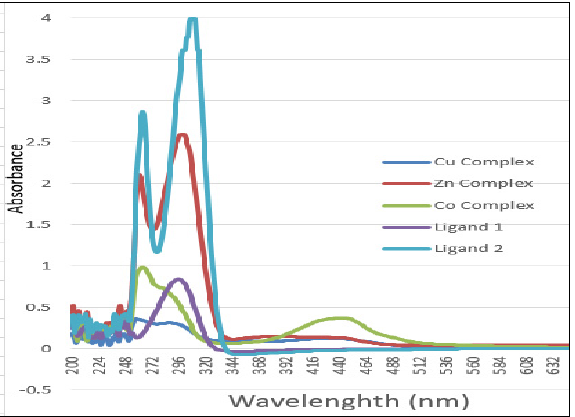
Figure 2. Electronic spectra of L1, L2, Co(II), Cu(II), and Zn(II) mixed ligand complexes.